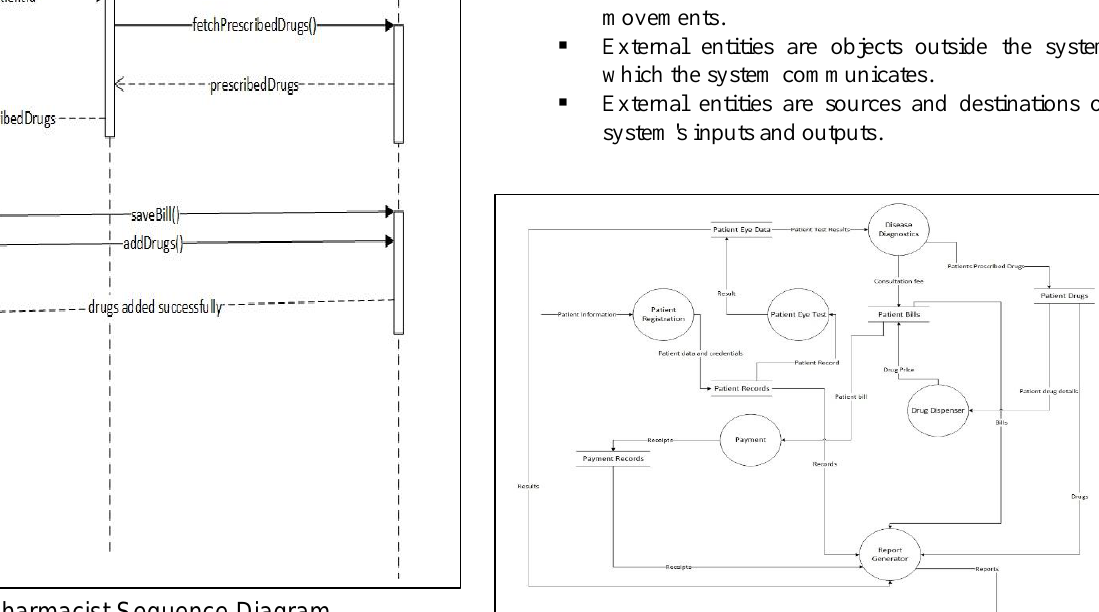
Figure 12. Pharmacist Sequence Diagram